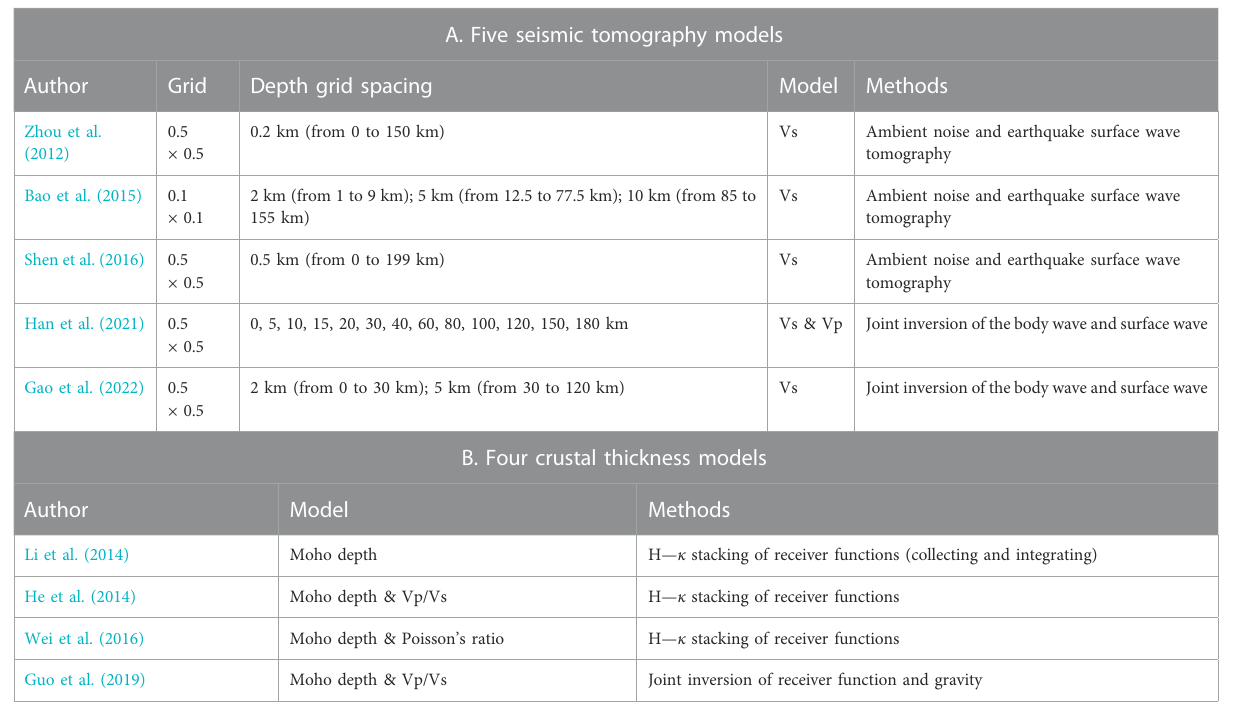
TABLE 1 Nine seismic models were used in this study. (A) Data resources of tomography inversion for the S-wave velocity model used in this study. (B) Data resources of receiver function for crustal thickness model used in this